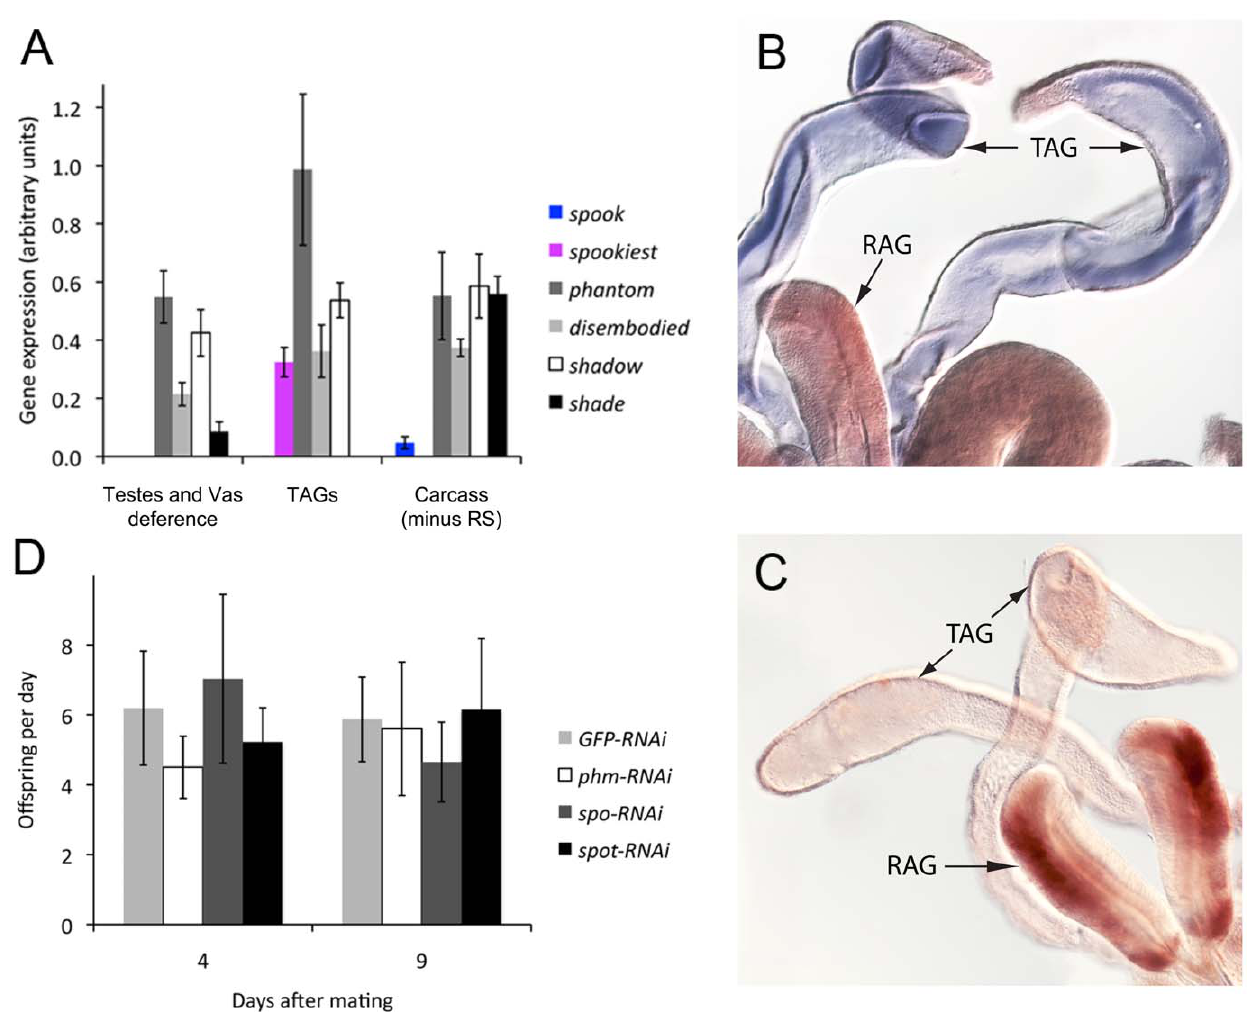
Figure 3. Tribolium male tubular accessory glands express the genes required for biosynthesis of E, but not 20E. (A) qPCR analysis shows that the tubular accessory glands express spot and the biosynthetic enzymes to produce E but not s hd , although E may be converted to 20E in other tissues as s hd is expressed in carcass (n=3–4). (B) In situ hybridization with a spot antisense probe showing expression in the TAGs. (C) Negative control in situ hybridization using a spot sense probe. (D) The fertility of males with reduced expression of key E biosynthetic enzymes was examined by the number of progeny produced per day of virgin females mated with males injected with dsRNA (n=6–7). Error bars are SE. RS; reproductive system, RAG; rod-shaped accessory gland, TAG; tubular accessory